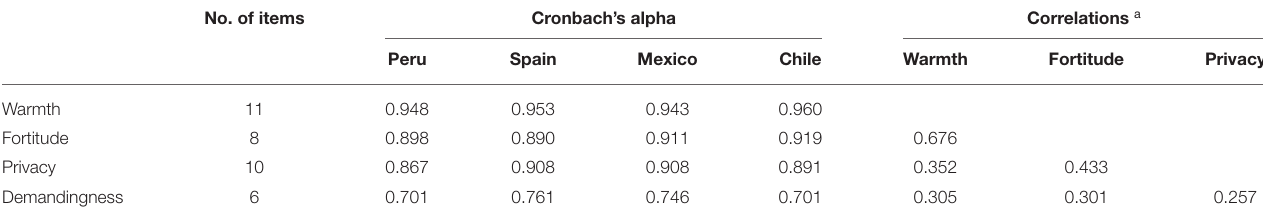
TABLE 5 | Internal consistency of the final scales, and correlations among